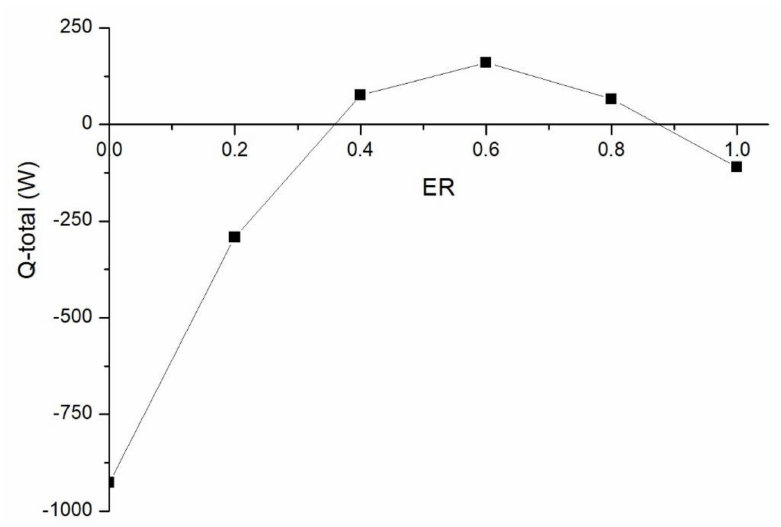
Figure 16. The e ff ect of ER on the simulation system heat output.